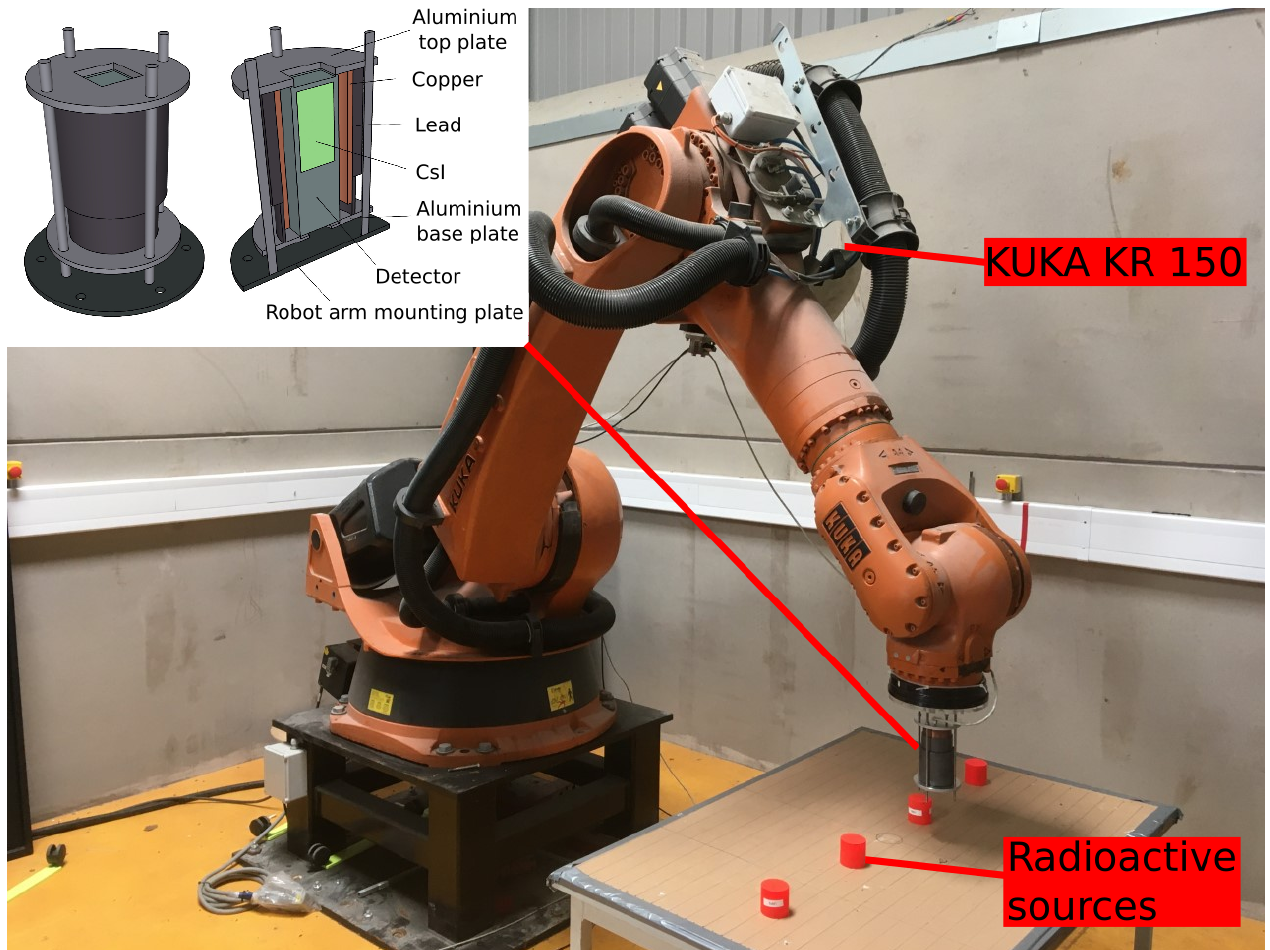
Figure 1. Photograph of the KUKA KR 150 system used, with a set of four sealed sources arranged on a table top. Inset—a detailed schematic of the detector and collimator